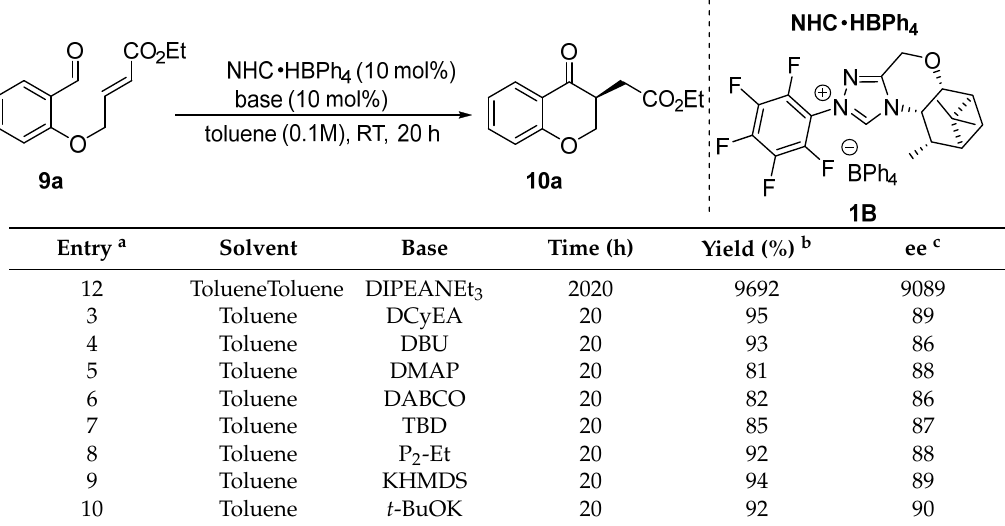
Table 2. Screening of bases.